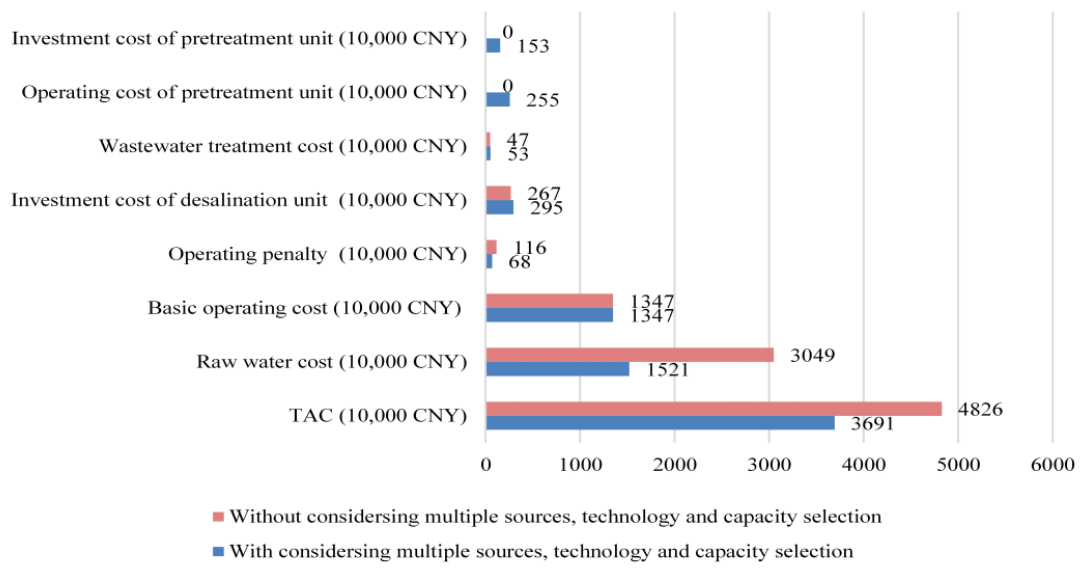
Figure 7. Comparison of costs with and without considering multiple water resources, unit technology, and capacity selection optimization (Scenario 3).